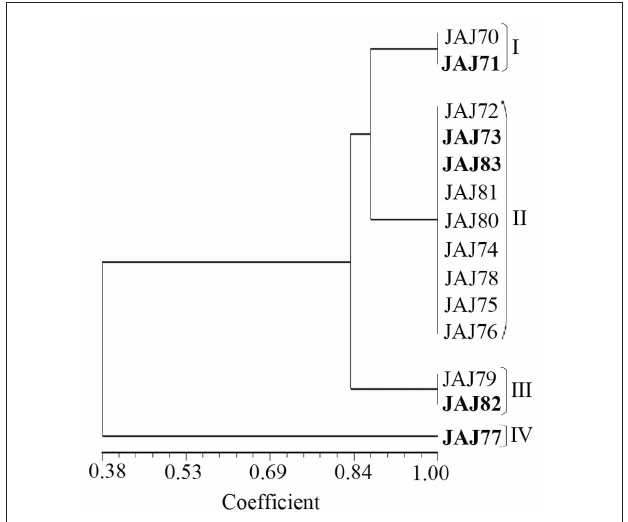
FIGURE 3 | UPGMA dendrogram shows the clustering of 14 actinomycete isolates generated from amplified ribosomal DNA restriction analysis with restriction endonuclease Hae III and Hinf I, using the UPGMA algorithm and the Jaccard’s coefficient. The Roman numerals I to IV represent the four clusters obtained in the analysis. The isolates subjected to sequencing analysis are highlighted in